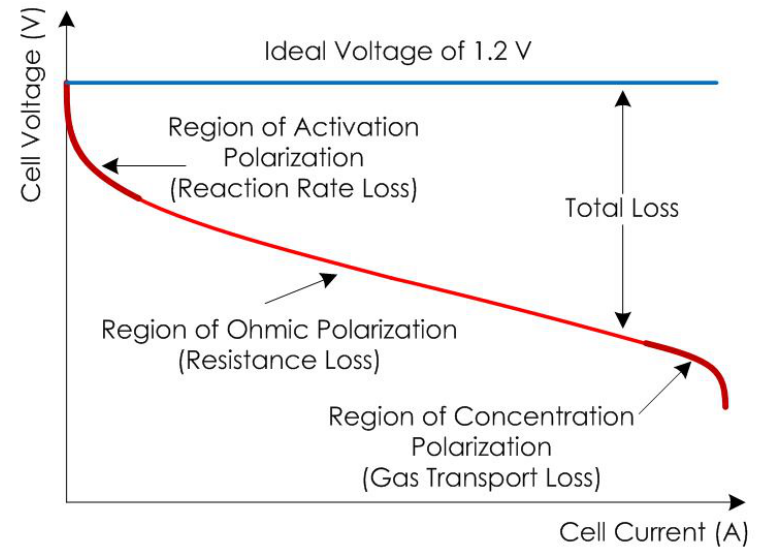
Figure 2. Ideal and real Fuel Cell Voltage